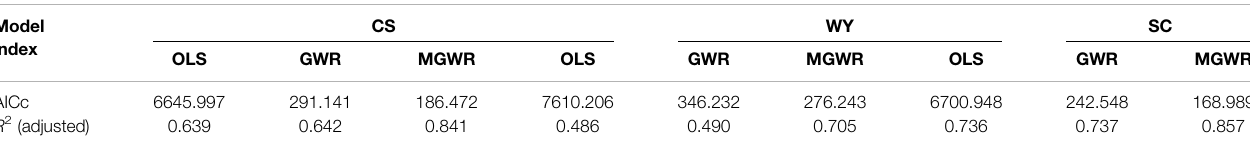
TABLE 4 | Comparison of the fi tting results of OLS, GWR, and MGWR. Model